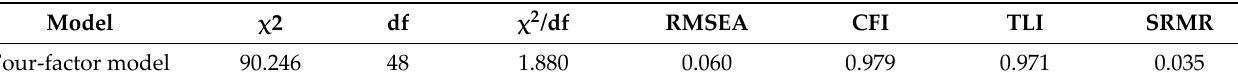
Table 3. Model Fit Index of OFPS‑P.